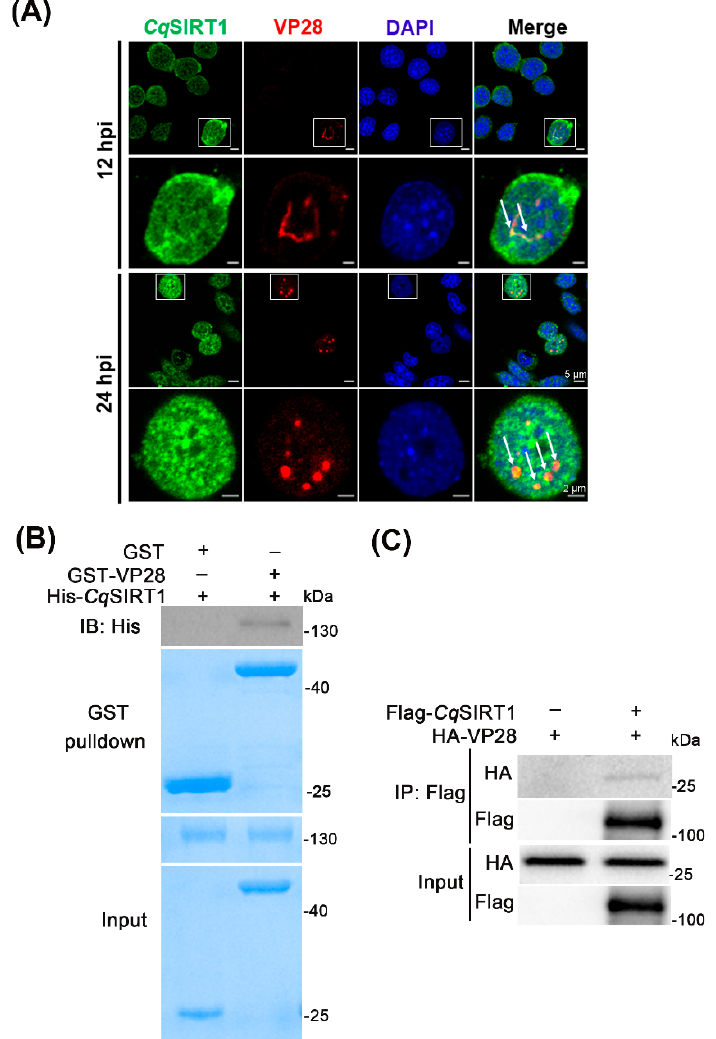
Figure 5. Cq SIRT1 was co-localized with and bound with VP28. ( A ) Cq SIRT1 was co-localized with VP28 in the nuclei of Hpt cells under a laser confocal microscope using specific antibodies against Cq SIRT1 (green) and VP28 (red). The arrow indicates co-localization. ( B ) GST pulldown assay between Cq SIRT1 and VP28 recombinant protein. The GST pulldown assay was performed, followed by Western blot analysis with anti-His monoclonal antibody. GST recombinant protein served as negative control. ( C ) Flag- Cq SIRT1 bound to HA-VP28 in the co-immunoprecipitation assay. Flag- Cq SIRT1 and HA-VP28 plasmids were co-transfected into HEK293T cell lines, then subjected to co-immunoprecipitation and Western blot analysis with the indicated specific antibody. These experiments were performed in biological triplicates.